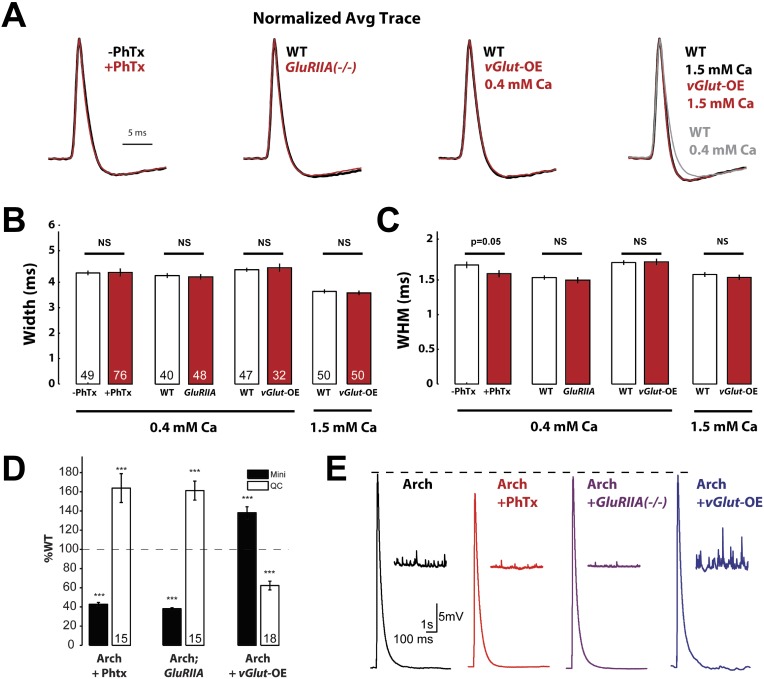
Action potential waveforms do not change during presynaptic homeostasis.(A) Normalized average AP traces comparing PhTx-treated, GluRIIA mutant, and vGlut-OE animals to WT animals. (B) AP width does not change in animals in which presynaptic homeostasis has been induced (n labeled within bars for all). (C) AP width at half maximum amplitude does not change in animals where presynaptic homeostasis has been induced, except for a small decrease in PhTx treated animals; p = 0.05; n for all is same as (B). (D) Quantal content homeostatically changes in response to perturbed mEPSP amplitude in animals that express Arch (p < 0.001, n labeled within bars for all). (E) Example traces of the data summarized in (D). [Ca]e = 0.4 mM, errors bars = SEM for all.